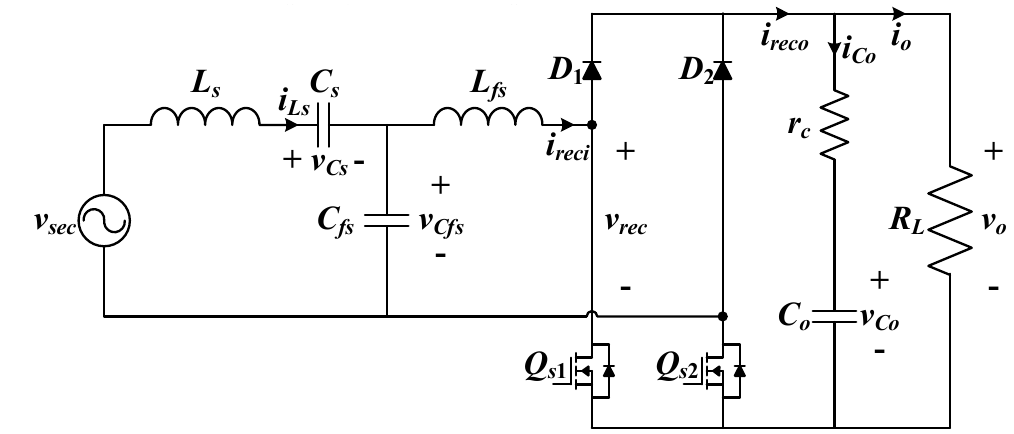
Figure 2. Secondary side equivalent circuit of double-sided LCC compensation topology with S-BAR.